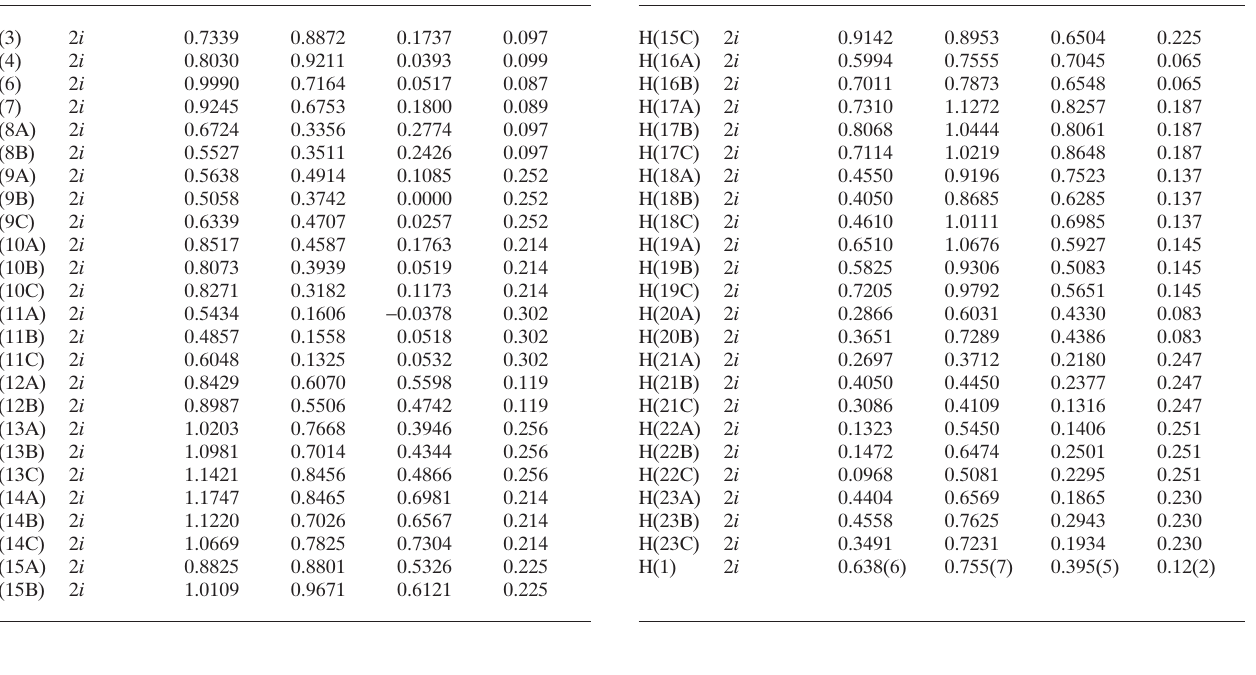
Table 3. Atomic coordinates and displacement parameters (in Å 2 ) .